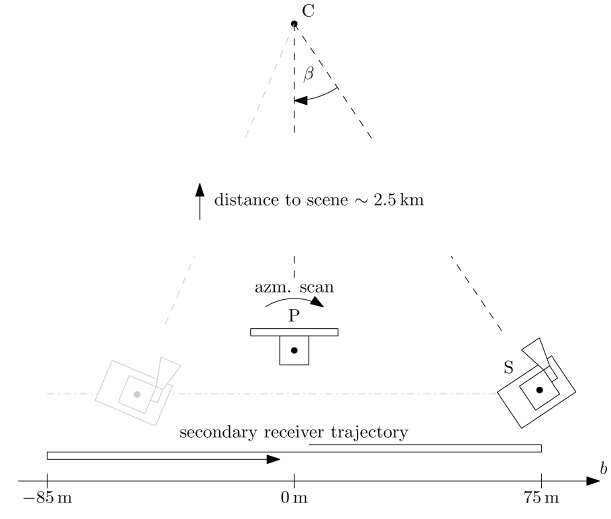
Figure 4. Diagram of the ground-based measurement procedure. The stationary, primary device P performs repeated azimuthal scans of the ROI around point C. To sample the scattering response of the ROI under a variety of bistatic angles β , the mobile secondary de- vice S is repositioned in between acquisitions. For both winter and summer experiments, S was placed at bistatic baselines b varying between − 85 and + 75m relative to